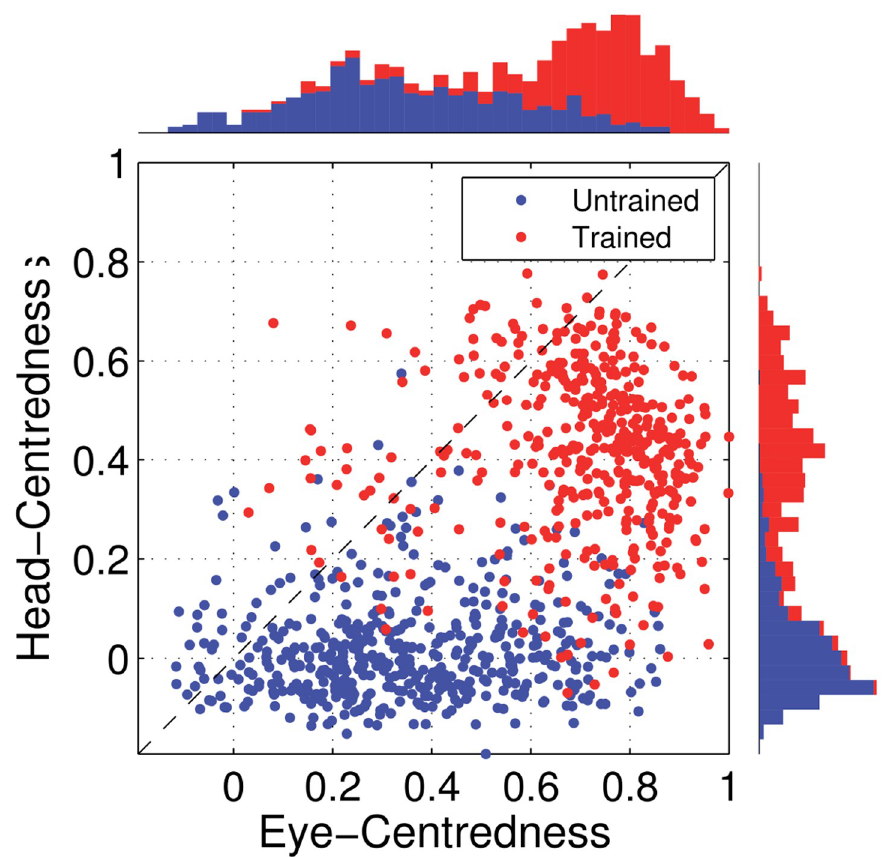
Fig 26. Simulation results of a model incorporating a mixed population of peaked and sigmoidal modulated input neurons, with sigmoidal modulation rate p set to 0.5, trained with the modified learning rule 20: Delayed postsynaptic trace learning rule. The scatter plot shows the reference frame response characteristics of all output neurons before and after training. Conventions as for Fig 14. It is evident that training had the effect of increasing the head-centredness values of most output neurons, with many more head-centred output neurons present in the trained model.